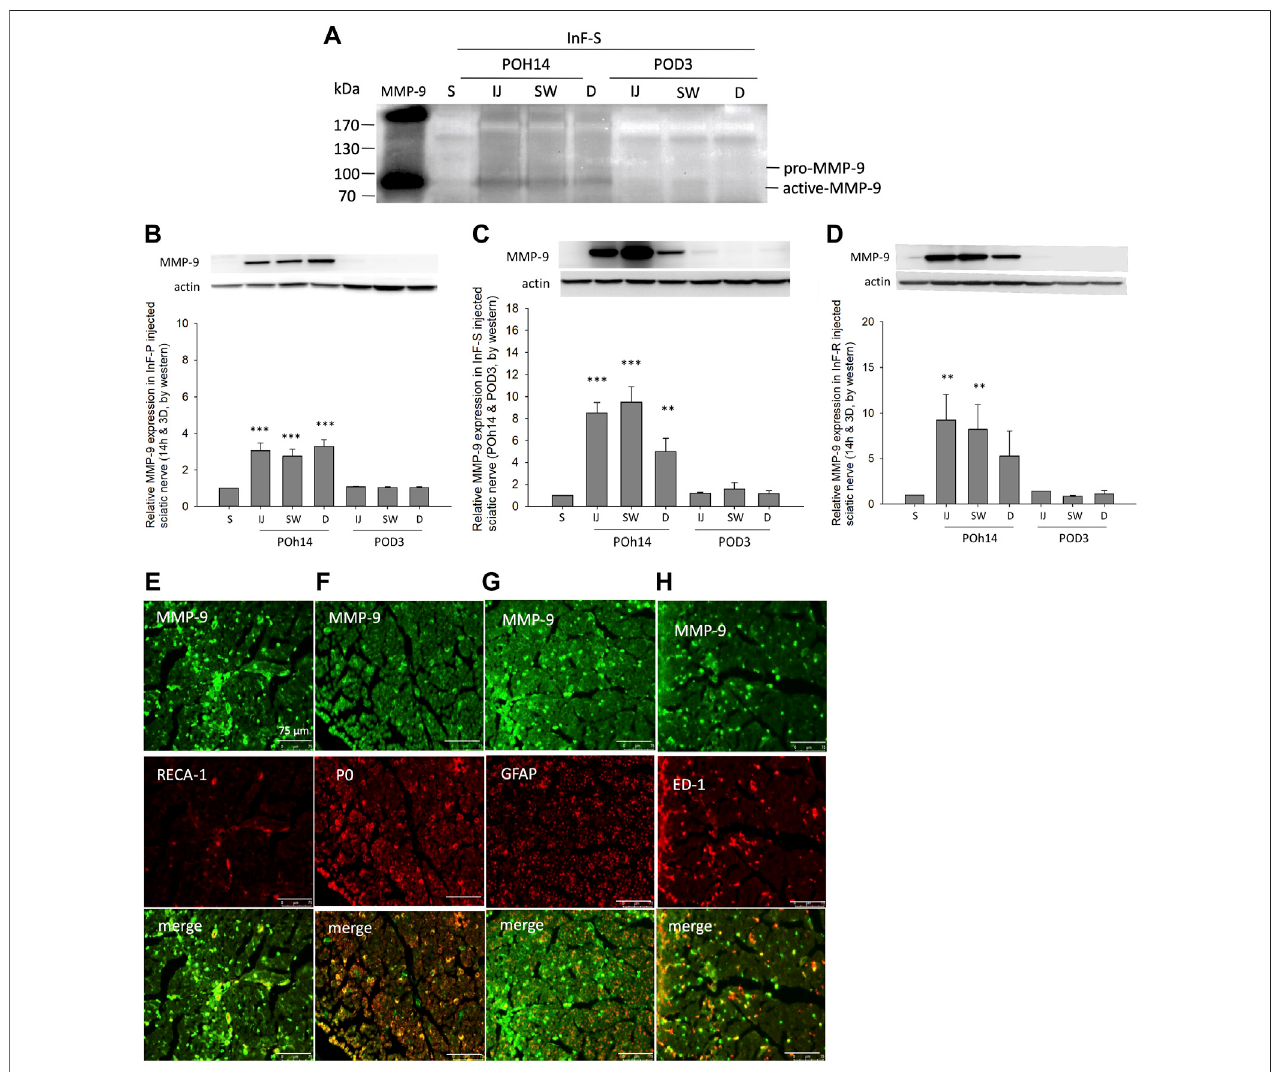
FIGURE 6 | MMP-9 activity and expression after intrafascicular injection (A) For gelatin zymography assay, 25 μ g of three distinct cross-sections of sciatic nerve from intrafascicular saline group was loaded on the gelatin-containing gels and analyzed. Increased MMP-9 activity was found at POh14. Western blots showed signi fi cantincreasesexpressionlevelofMMP-9insciaticnervesof (B) needlepiercinggroup(InF-P) (C) intrafascicularsalineinjectiongroup(InF-S)and (D) Intrafascicular ropivacaine injection group (InF-R) at POh14. Double immuno fl uorescence staining of MMP-9 with (E) RECA-1 (F) P0 (F) GFAP, and (G) ED-1 in sciatic nerve swollensiteingroupInF-SonPOD3wereshown.Scalebar:75 μ m.POD,post-operation-day;injectionsite(IJ),swollensite(SW),distalsite(D)ofsciaticnerve.S:sciatic nerve of sham group, One-way ANOVA. Error bars represent SE. *** p < 0.001, ** p < 0.01.